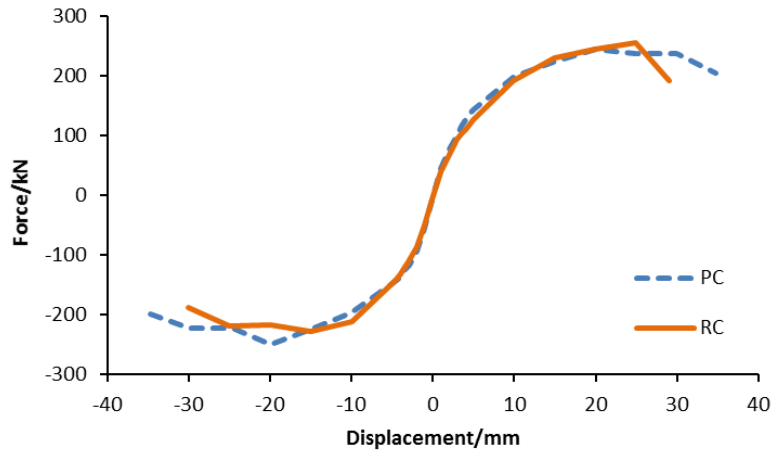
Figure 11. Skeleton curves.